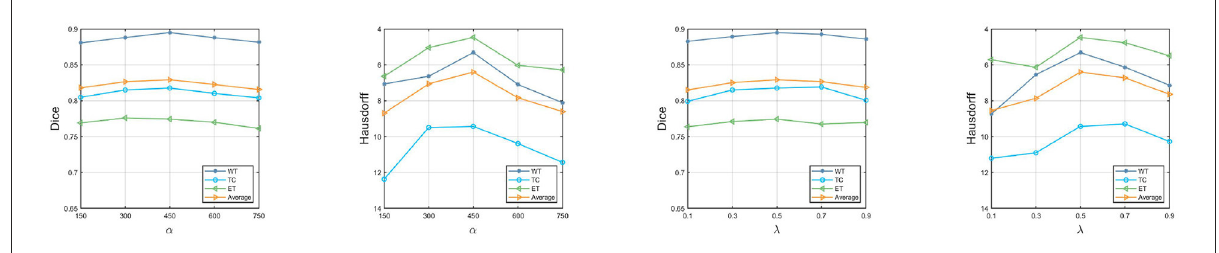
FIGURE6 Impact of the parameters α and λ on the model performance.